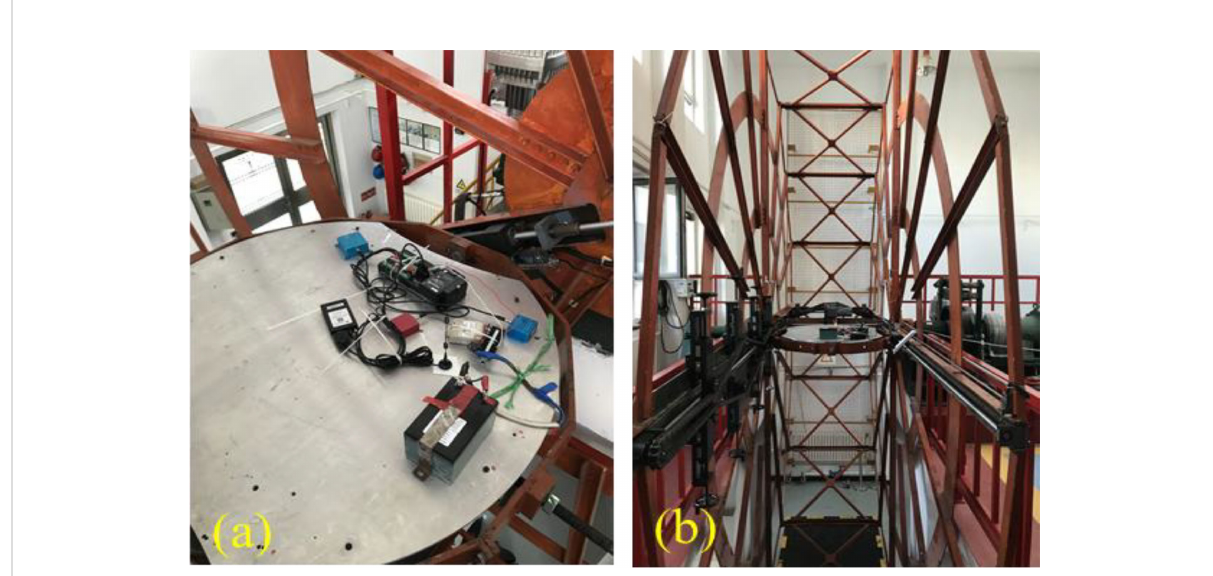
FIGURE 9 Wave simulation turnable: (A) Installation of DWS19-2 and data acquisition system (B) Turntable simulator